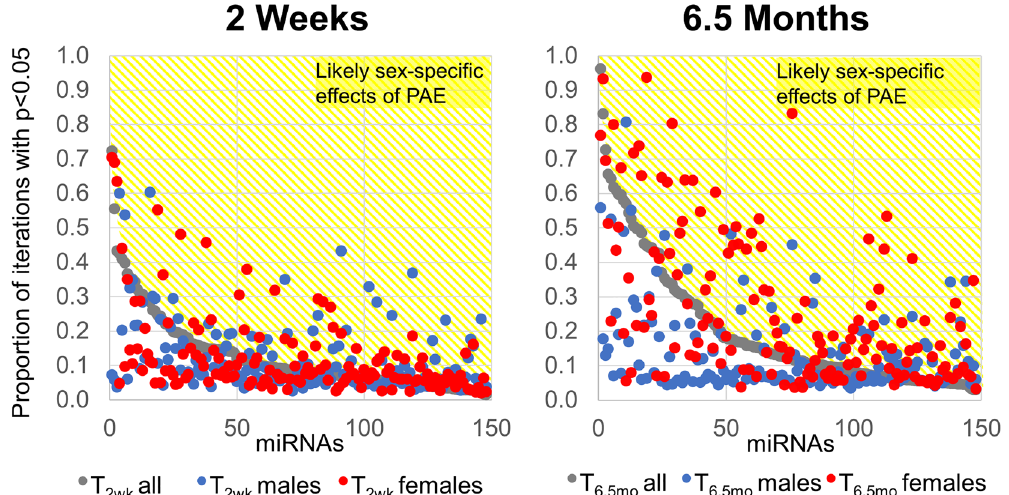
Figure 3. Sexually dimorphic changes in ex miRNAs in response to PAE. Bootstrap resampling of ex miRNA expression at T 2wk (left) and T 6.5mo (right). The population including both male and female samples (gray) was resampled 2000 times with replacement and the proportion of significant p -values (ANCOVA with cigarettes/ day as a covariate) across the iterations is shown. The population was then resampled with only male (blue) or only female (red) infants. ex miRNAs that were more likely to be significantly altered when examined in a single sex than in the combined population are in the yellow region and are likely to be altered in a sex-specific manner in response to